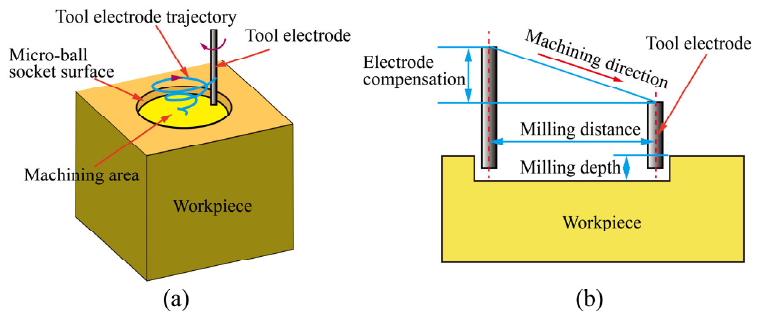
Figure 1. Micro-ball socket milled by micro-EDM. ( a ) Schematic diagram of micro-ball socket milled Figure 1. Micro ‐ ball socket milled by micro ‐ EDM. ( a ) Schematic diagram of micro ‐ ball socket milled by micro ‐ EDM ( b ) Schematic diagram of electrode linear compensation. by micro-EDM ( b ) Schematic diagram of electrode linear